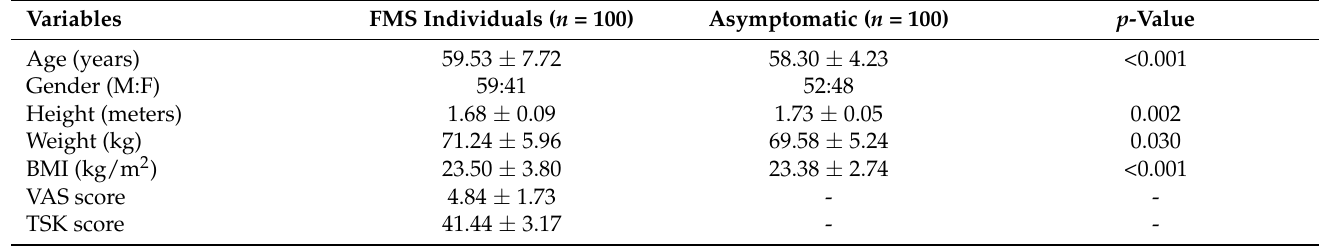
Table 1. Demographic characteristics and physical parameters of the FMS and asymptomatic indi- viduals.